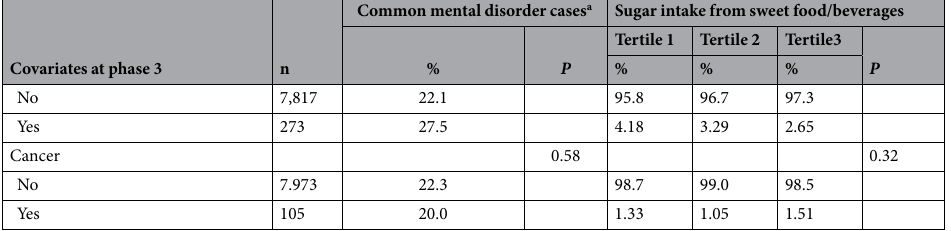
Table 1. Crude association of common mental disorder and sugar intake from sweet food/beverages with covariates at phase 3. Abbreviations: SD = Standard Deviation, CVD = cardiovascular disease, DASH = Dietary Approaches to Stop Hypertension. P for difference or heterogeneity, derived from t-test, chi-square test, ANOVA or Kruskal-Wallis test. a Common mental disorder measured using the 30-item General Health Questionnaire.